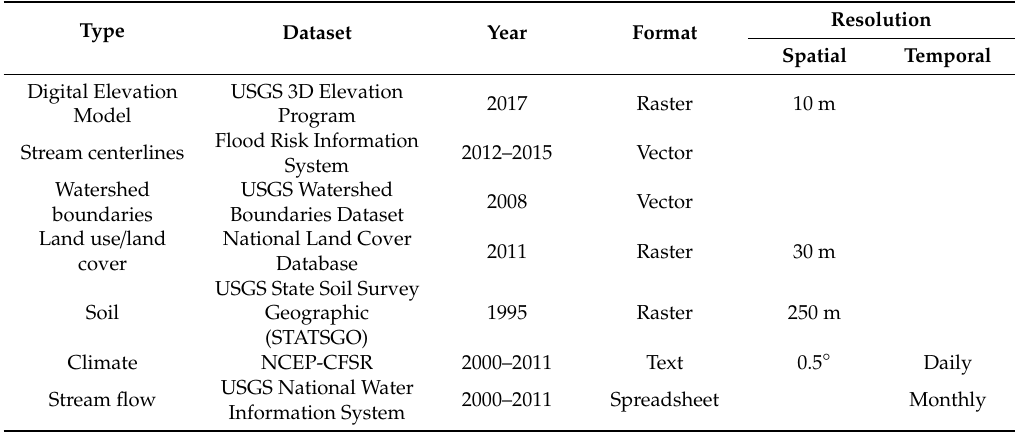
Table 3. Record of data used in this study, sources, and spatial and temporal resolutions if